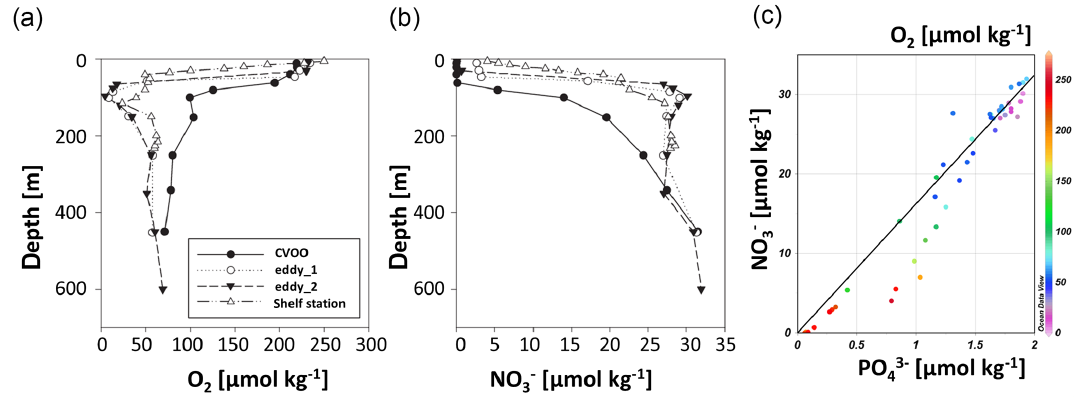
Figure 3. (a) O 2 and (b) nitrate and (c) nitrite concentrations measured at the open-ocean station CVOO (black circles), in the first observation (eddy_1, open circles), second observation (eddy_2, black triangles) and on the Mauritanian shelf (open triangles). (d) Nitrate vs. phosphate concentration at the four sampling stations. The color code denotes the O 2 concentration and the black line indicates the Redfield ratio of N:P = 16:1.